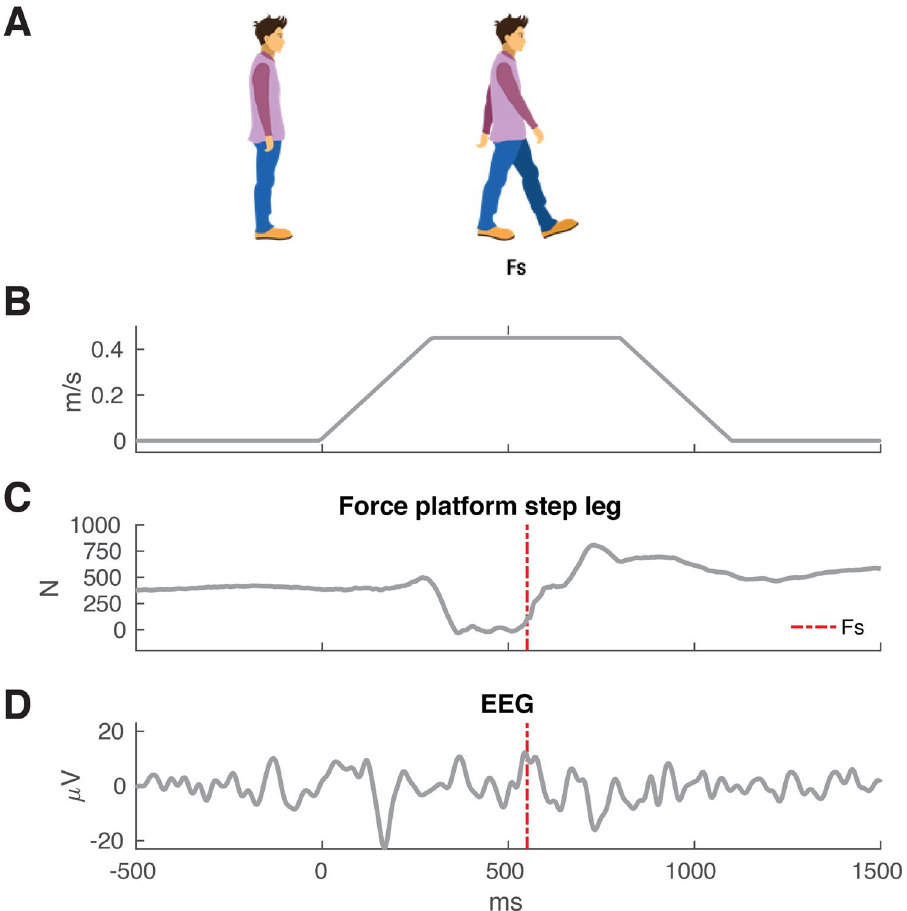
Figure 1. Experimental data alignment. ( A ) The participant’s response to a forward perturbation (i.e. backward platform translation). Foot strikes (Fs) were identified from the force plate and marker data. ( B ) The perturbation profile used in the experiment expressed in velocity over time. The total perturbation duration was 1.1 s. ( C ) Vertical forces measured underneath the stepping leg, with the vertical dashed line indicating the instant of foot strike of the stepping leg (Fs). ( D ) Trial-specific Fs time stamps were used to time- lock EEG data for data analysis. For illustration purposes, EEG data shown in this figure is 10 Hz low-pass filtered single-trial EEG data time-locked to perturbation